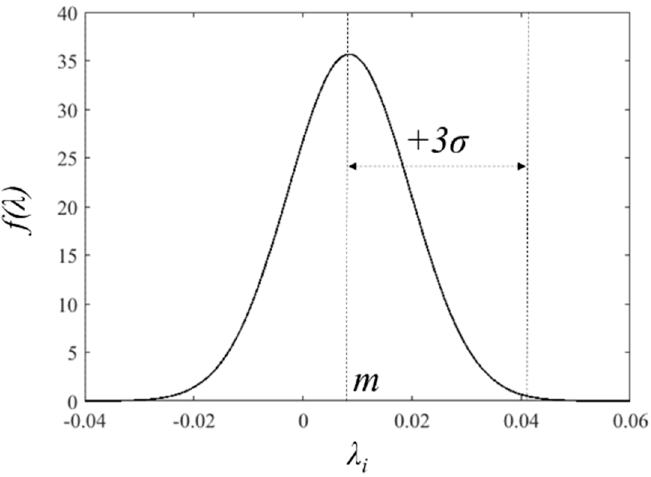
Figure 6. Normal distribution of λ i .